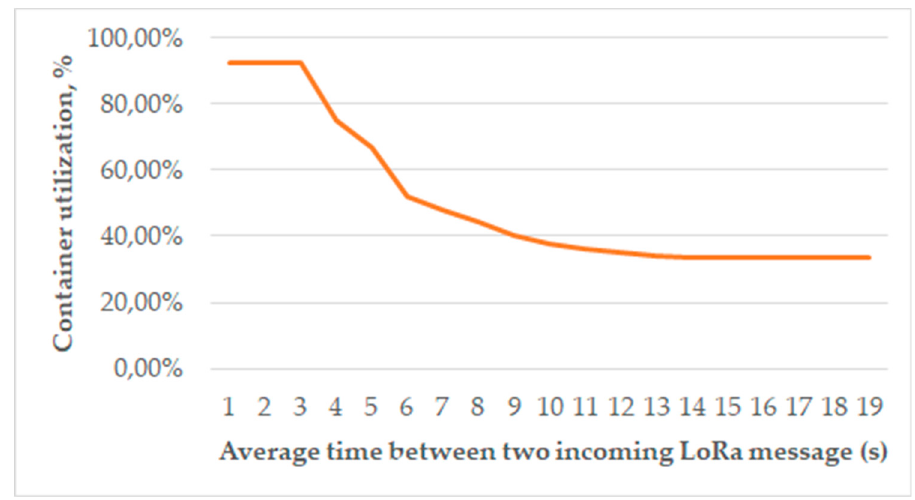
Figure 8. Container utilization with packaging applied.